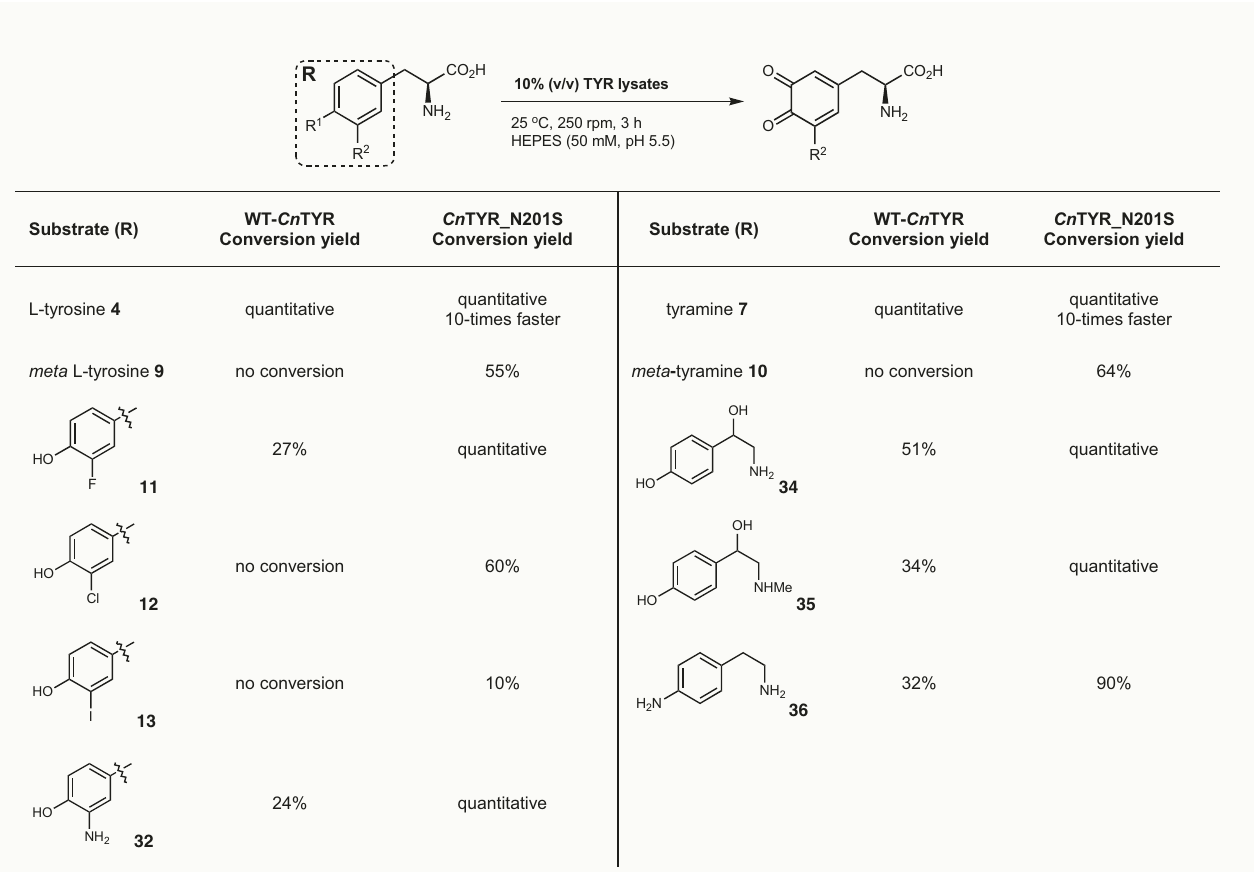
Table 3 | Comparison of the conversion yields of the wild-type Cn TYR and Cn TYR_N201S towards different substrates